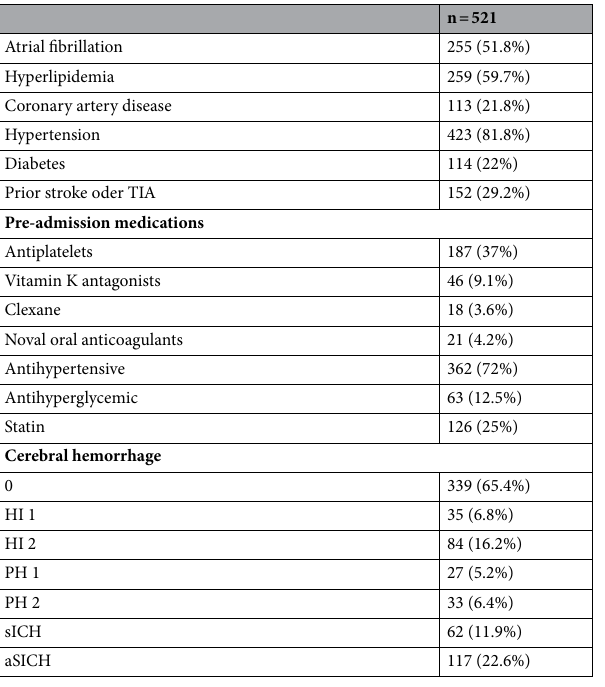
Table 1. Baseline characteristics of the study population. Age is mean value with standard deviation, other data are median values with inter-quartile range in parentheses or numbers with percentages in parentheses. NIHSS National Institutes of Health Stroke Scale, mRS modified Rankin Scale, ESUS Embolic Stroke Undetermined Source, ASPECTS Alberta Stroke Program Early CT Score, CBF cerebral blood flow, vSS Van Swieten Scale, TICI thrombolysis in cerebral infarction, SBP systolic blood pressure, DBP diastolic blood pressure, TIA transient ischemic attack, HI Hemorrhagic infarction, PH Parenchymal hematoma, sICH symptomatic intracerebral hemorrhage, aSICH ssymptomatic intracerebral